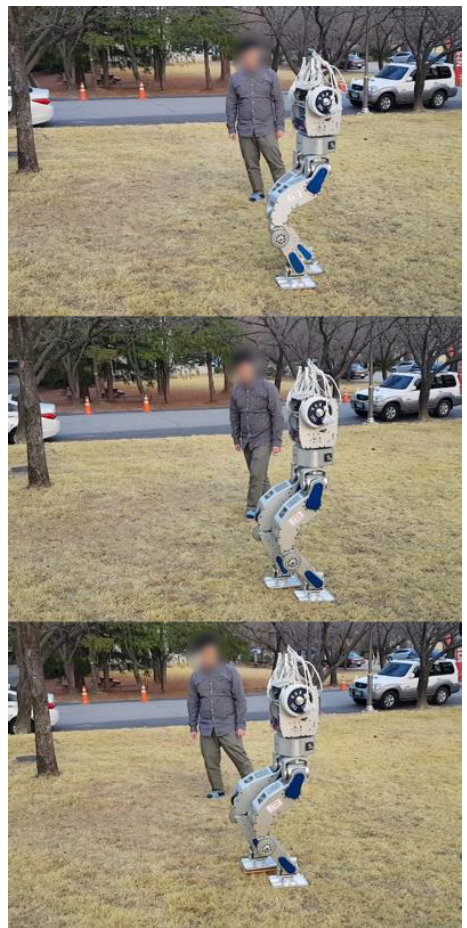
Figure 23. Snapshots from the walking experiment on a lawn.